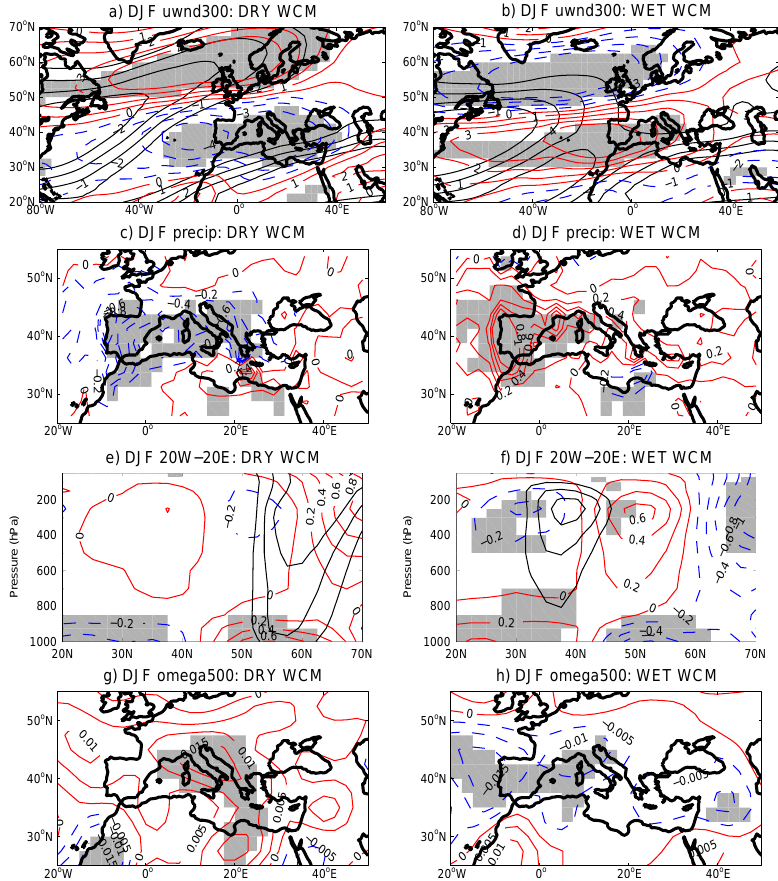
Fig. 12. Same as Fig. 11, but for winter: years when the western-central Mediterranean was drier than normal in the left panels; years when the western-central Mediterranean was wetter than normal in the right